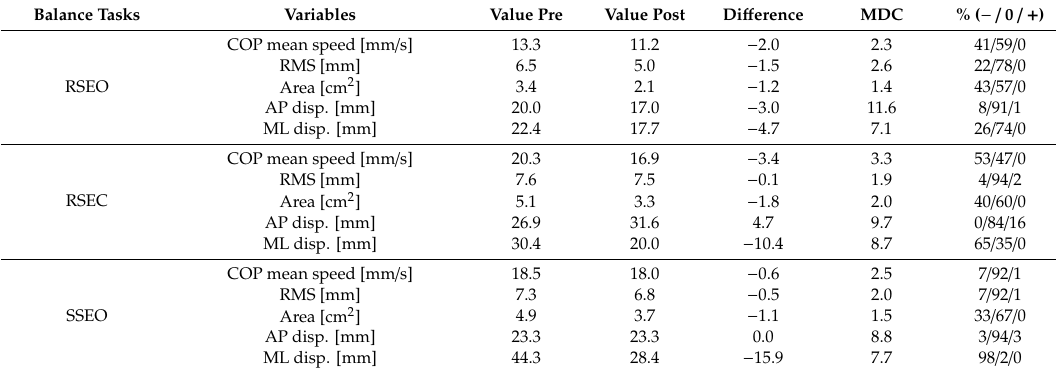
Table 3. Results of the patient